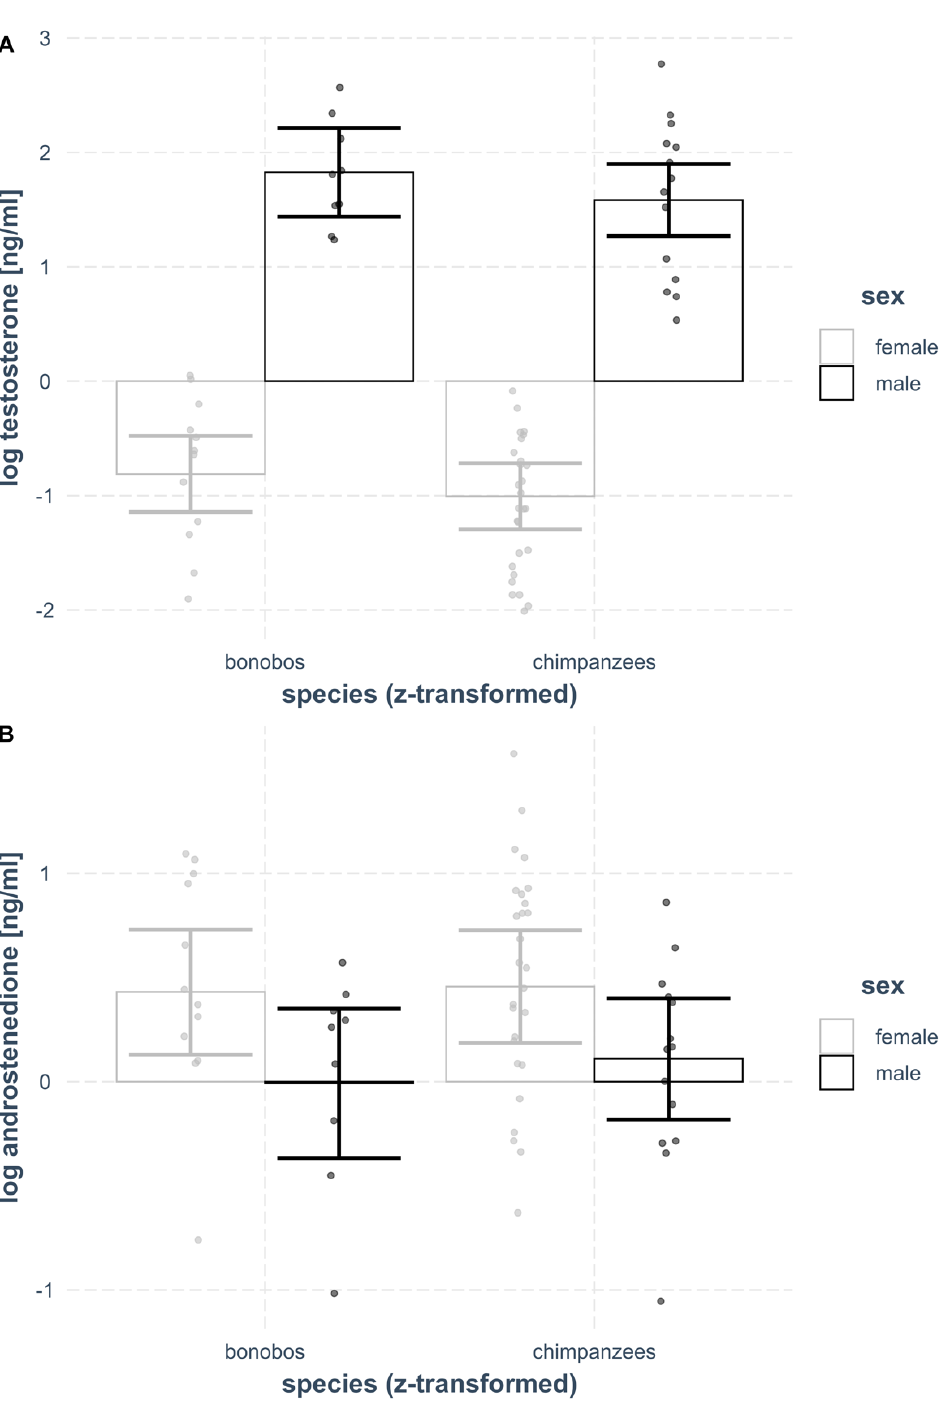
Figure 1. Bonobo and chimpanzee ( A ) plasma testosterone and ( B ) plasma androstenedione levels by species and sex. ( A ) The upper plot shows that females (light grey bars) of either species (bonobos on the left, chimpanzees on the right of the plot) had significantly lower plasma testosterone levels (log-transformed values on the y-axis) than males (black bars) of the respective species. ( B ) Female plasma androstenedione levels were higher than male levels in both Pan species, as depicted in the lower